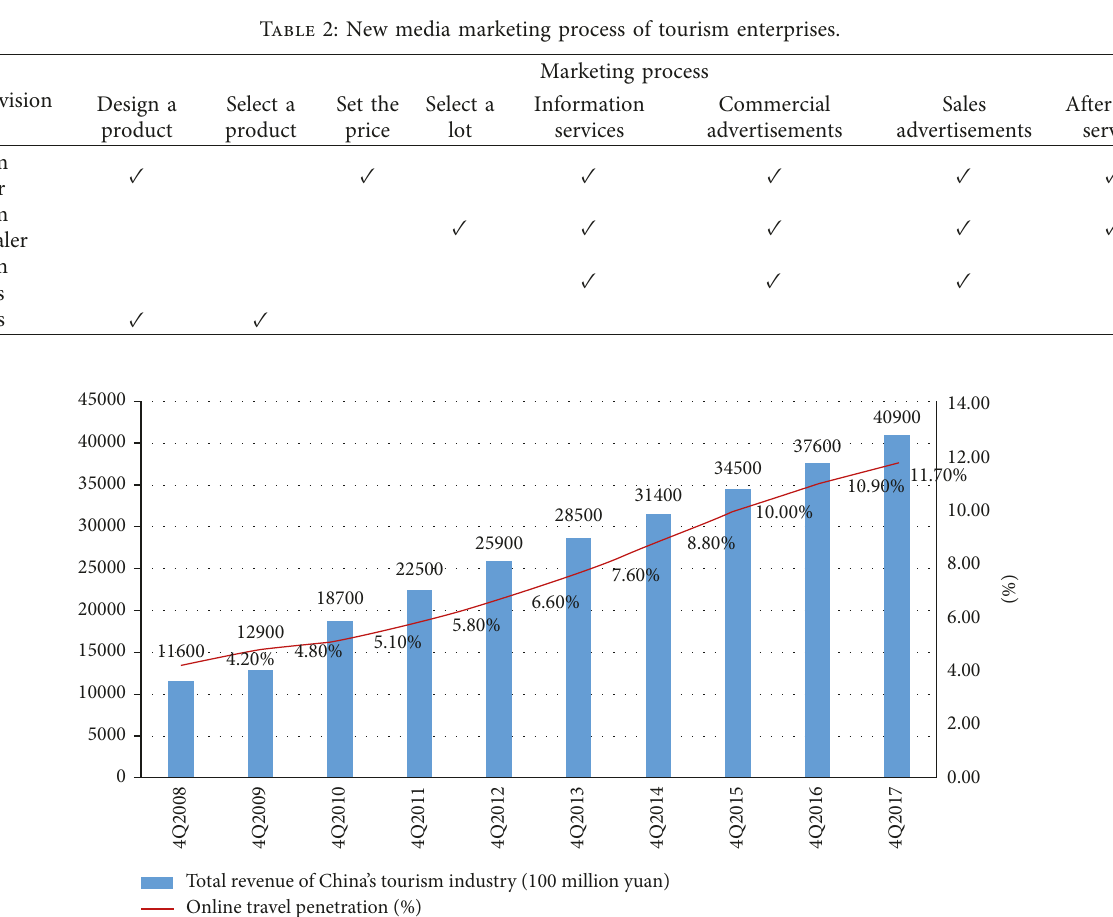
Figure 2: Total tourism revenue and online travel penetration rate in China from 2008 to 2017.